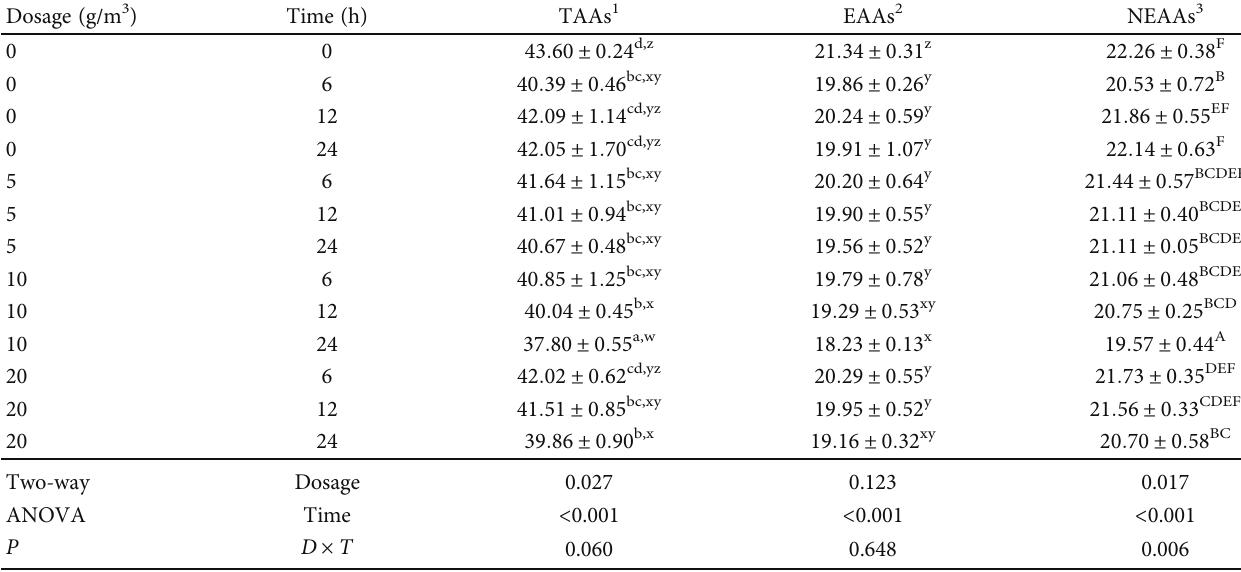
Table 3: Amino acid composition analysis of live prey enrichment.